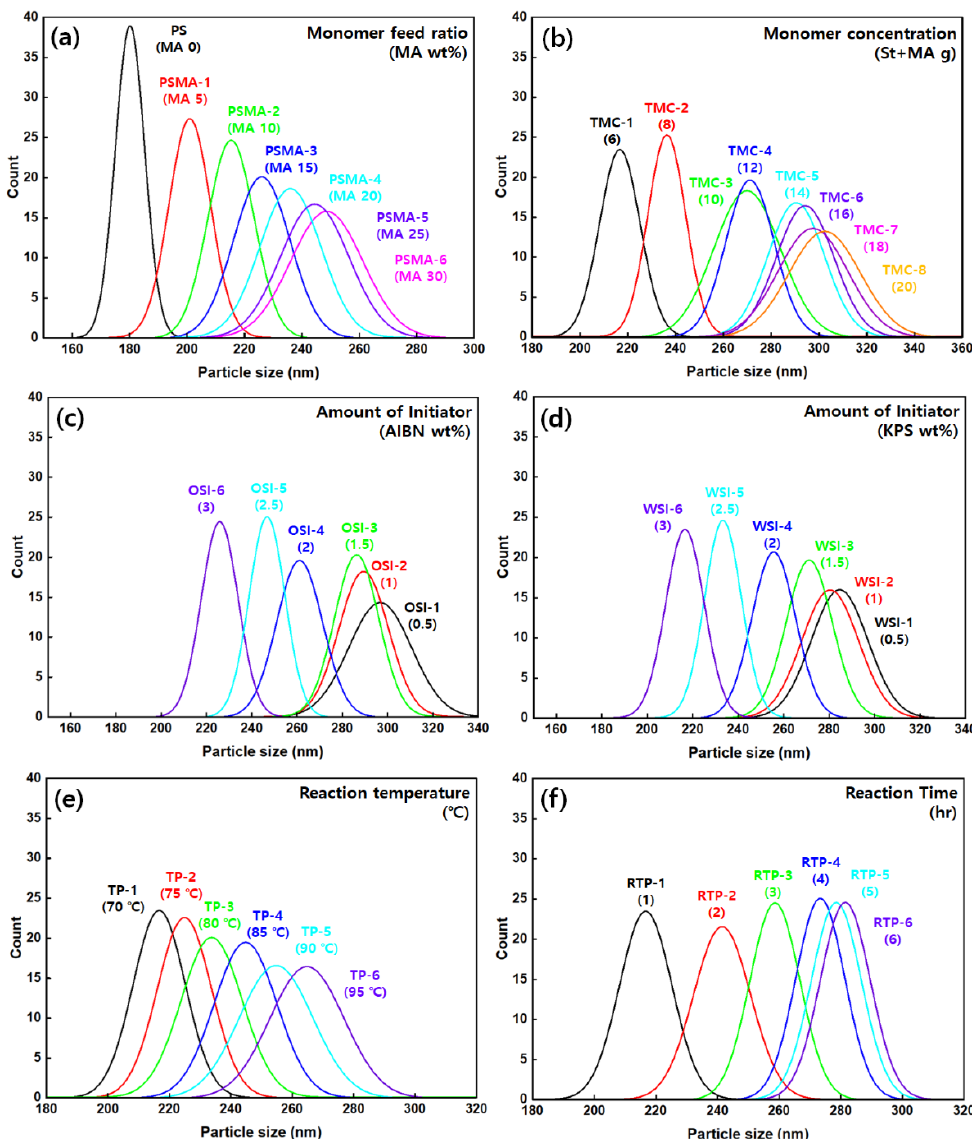
Figure 3. Particle size distribution of PSMA with respect to the ( a ) monomer (MA) ratio, ( b ) monomer concentration, ( c ) effect of oil-soluble initiator (AIBN), ( d ) effect of water-soluble initiator (KPS), ( e ) reaction temperature, and ( f ) reaction time.